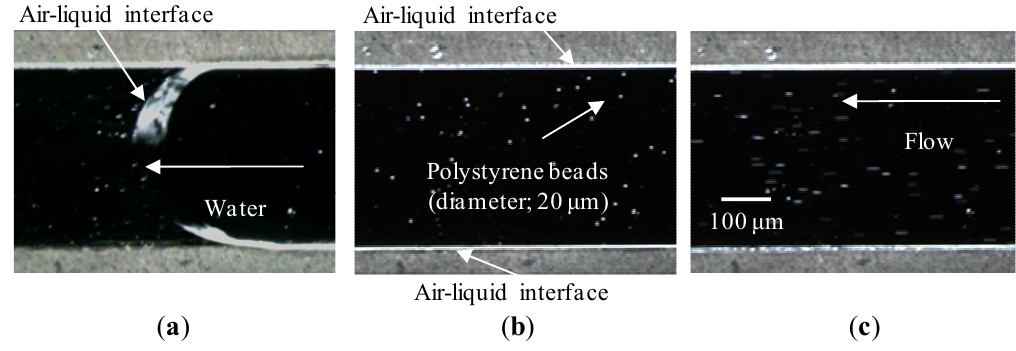
Figure 7. Demonstration of surface-directed liquid flow. ( a ) Introduction of water, ( b ) forming of air-liquid interface and ( c ) transportation of